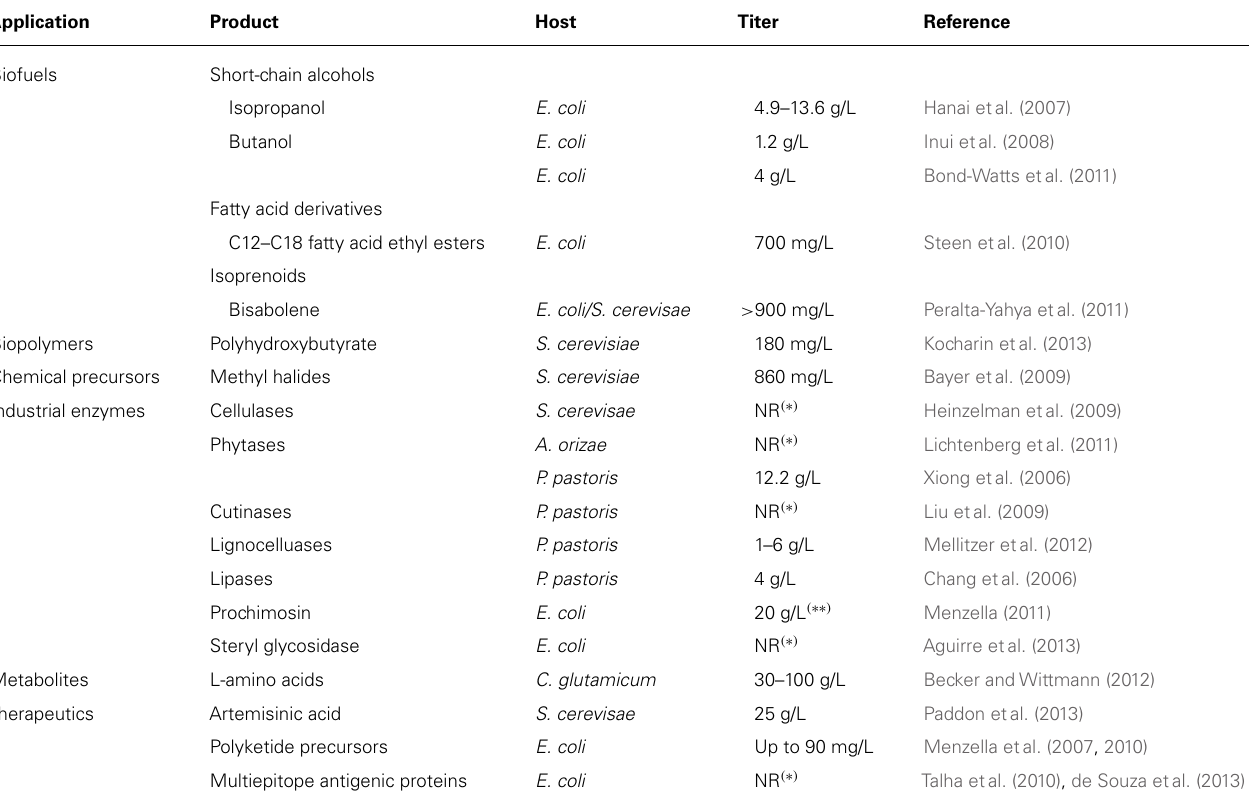
Table 1 | Expression of redesigned genes of industrial interest in microbial